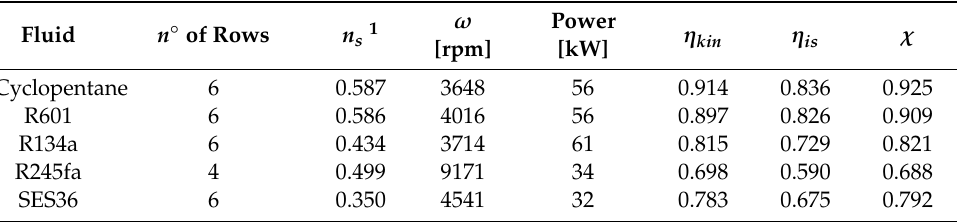
Table 8. Crucial design parameters for di ff erent working fluids.